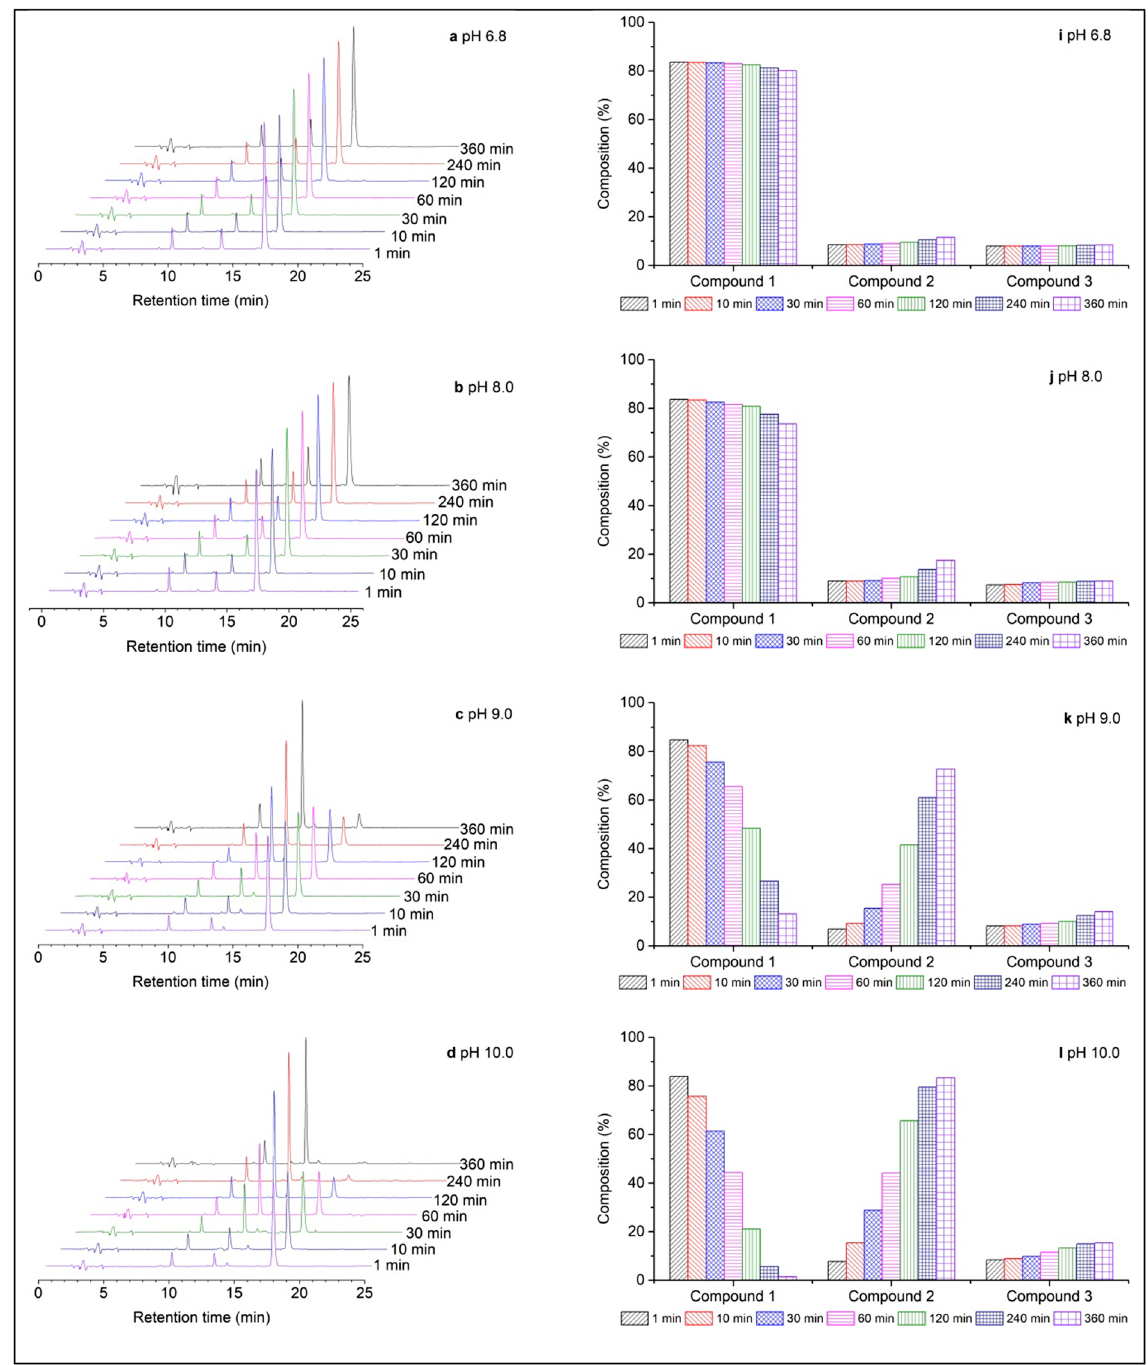
Figure 2. HPLC chromatograms of Red 2 dye solution ( a – g ) and the composition percentage of corresponding compounds ( i – o ) and the completely hydrolyzed solution ( h ); the pseudo first-order hydrolyzed velocity constant ( p